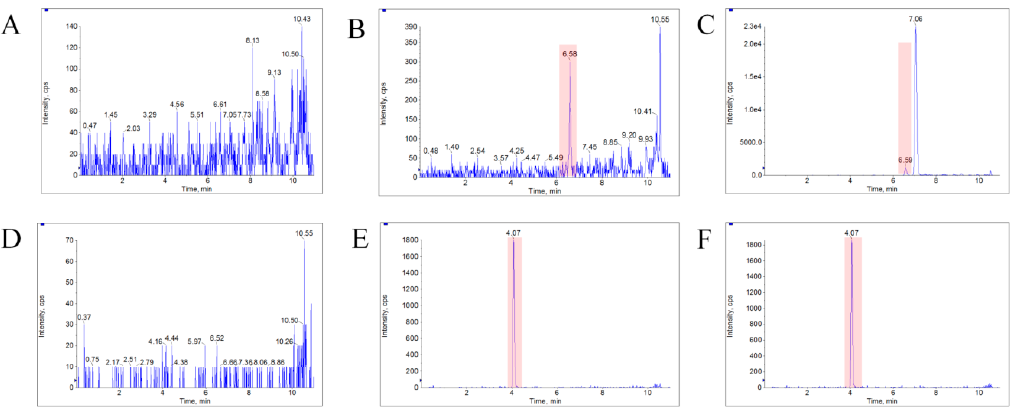
Figure 3. The typical MRM chromatograms of bufalin and IS. ( A ), ( B ), and ( C ) represent the bufalin in blank blood, blank plasma spiked with bufalin (LLOQ), and plasma sample from a rat with a single dose of 10 mg/kg bufalin, respectively. ( D ), ( E ), and ( F ) represent the IS, likewise. Table 4. Precision and accuracy for bufalin in rat plasma ( n = 6).